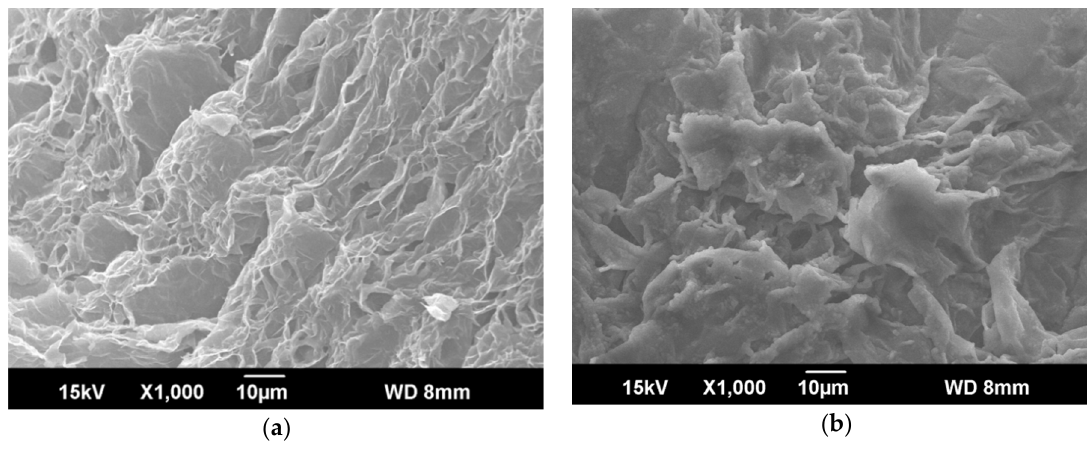
Figure 3. Microstructures of ( a ) EG and ( b ) CA–MA/EG.